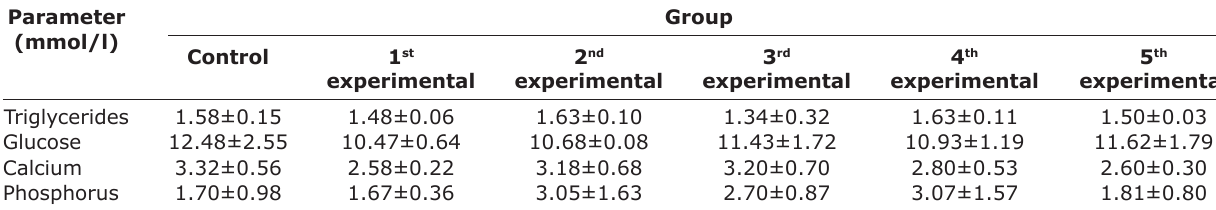
Table-3: Biochemical parameters of the blood of broiler chickens, characterizing carbohydrate, lipid and mineral metabolism. Parameter